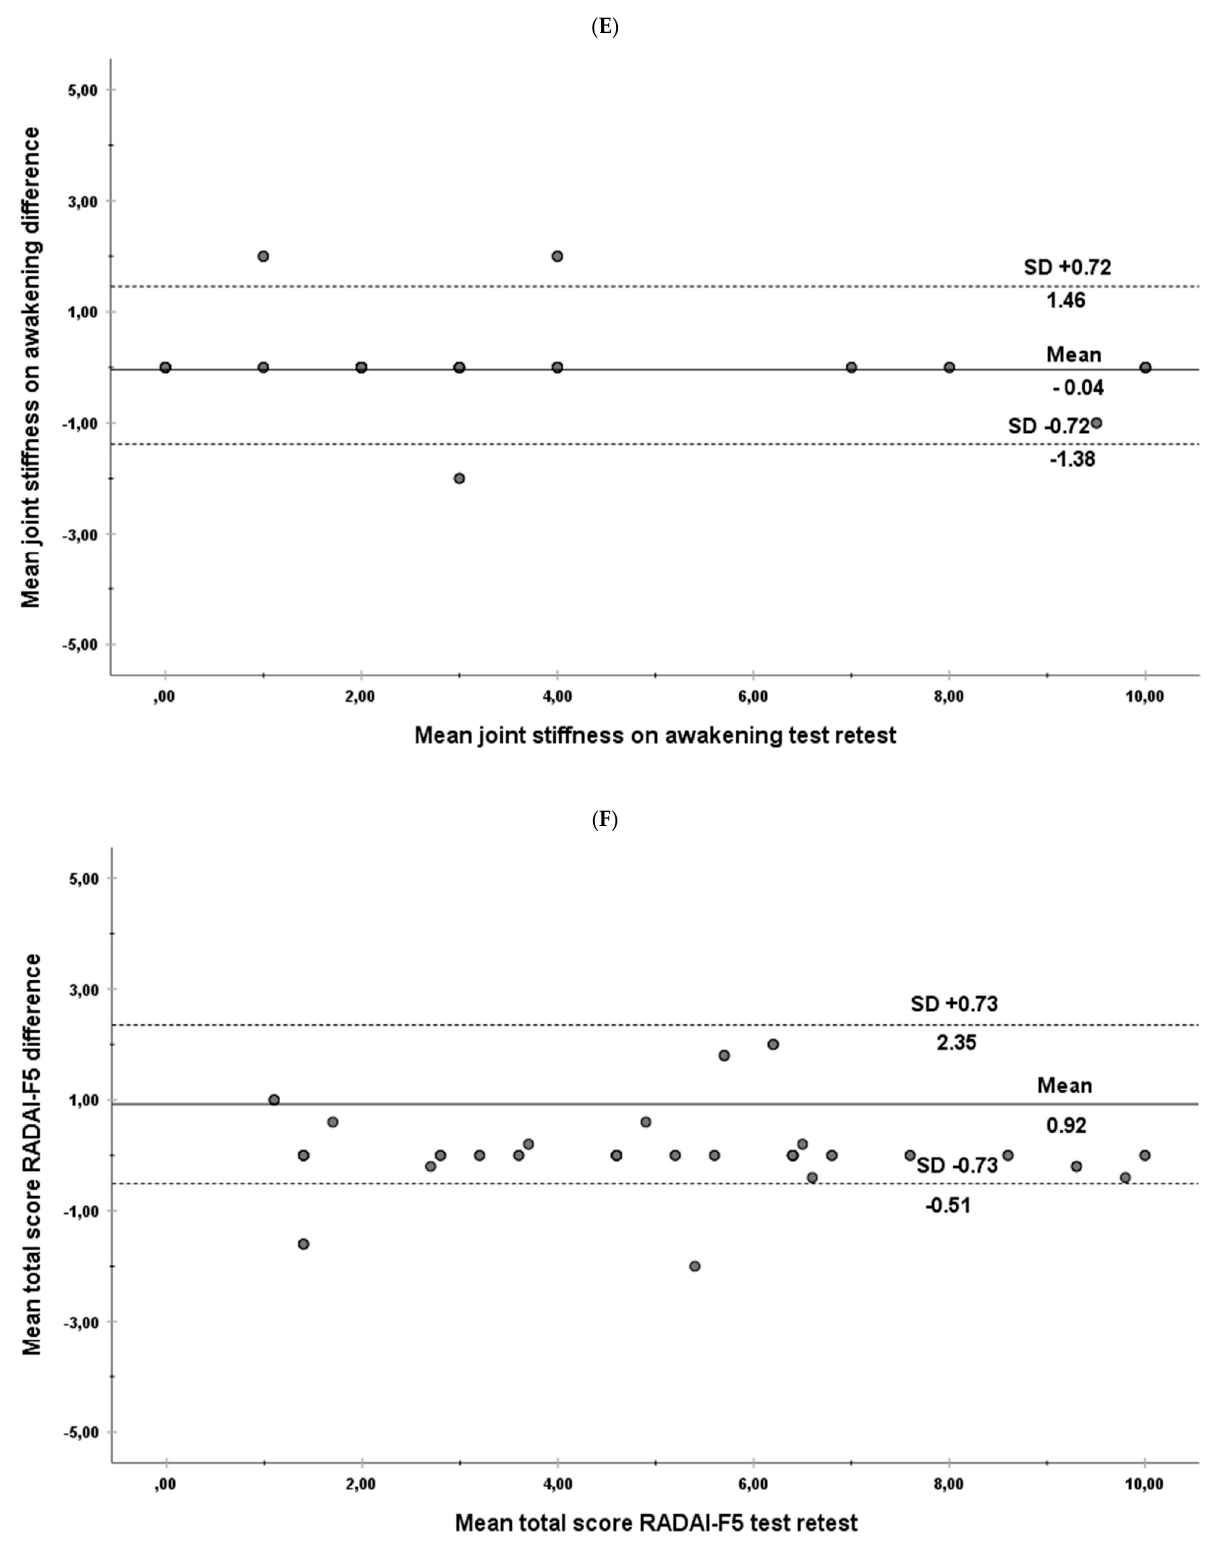
Figure 1. Altman plot showing the agreement between test and retest for the individual subscales and the total score. Dimensions: ( A ) arthritis activity in foot, ( B ) joint tenderness and swelling, ( C ) foot arthritis pain, ( D )general foot health, ( E ) joint stiffness on awakening sub-scales. ( F ) total score RADAI-F5.